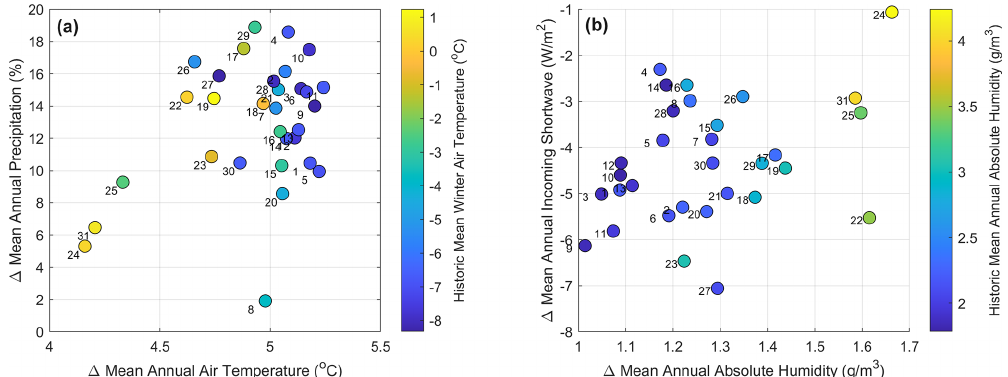
Figure A5. Mean annual climate changes projected by WRF under a RCP8.5 pseudo global warming scenario by the end of the century. Panel (a) shows changes in precipitation against air temperature. Panel (b) shows incoming shortwave against absolute humidity. Numbers represent the gauge IDs as presented in Table